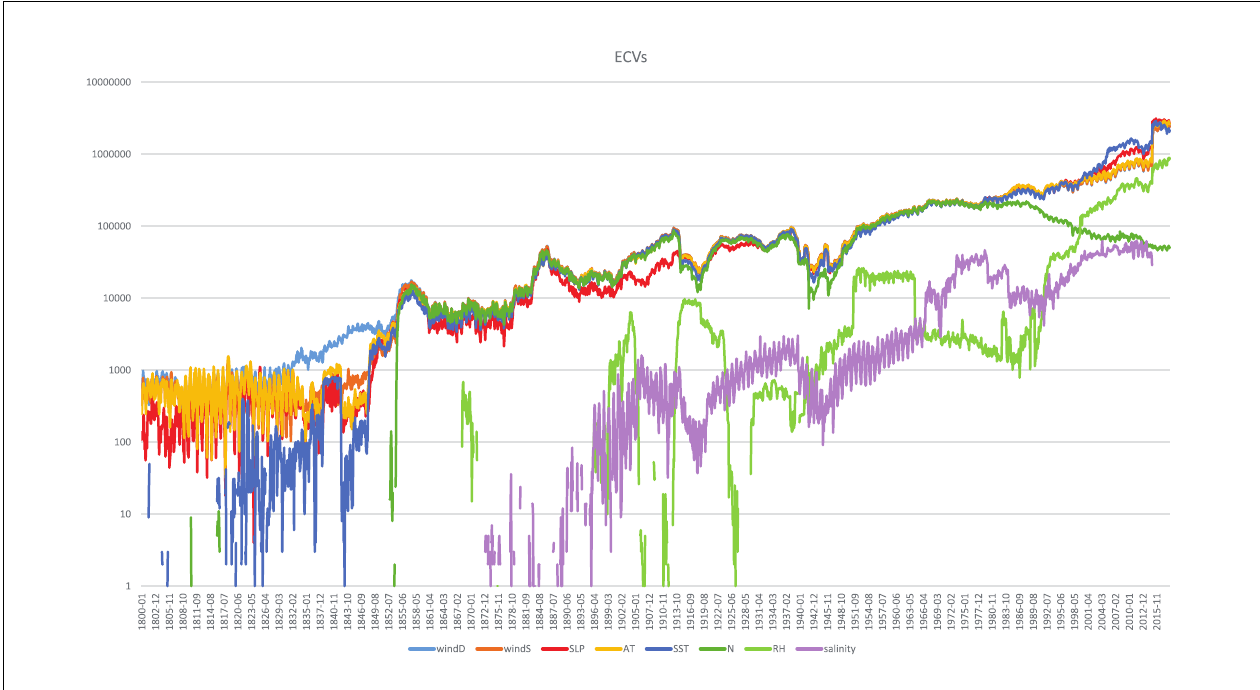
FIGURE 2 | Essential Climate Variables (ECVs) in International Comprehensive Ocean-Atmosphere Data Set (ICOADS) R3.0.0 and R3.0.1 from January 1800 to September 2018: windD, wind direction; windS, wind speed; SLP, sea level pressure; AT, air temperature; SST, sea surface temperature; N, total cloud amount; RH, relative humidity; salinity, sea surface salinity. The y axis is in a log 10 scale and shows the number of reports per month for those ECVs listed.Some elements are highly variable in their availability, especially in the early period of record. In the modern period there are noticeable decreases in ECVs, i.e., cloud observations and even SST. Some of these, i.e., clouds, are attributed to changes from manual observations to automated observation systems, where humans have not been replaced by sensors to continue observing the